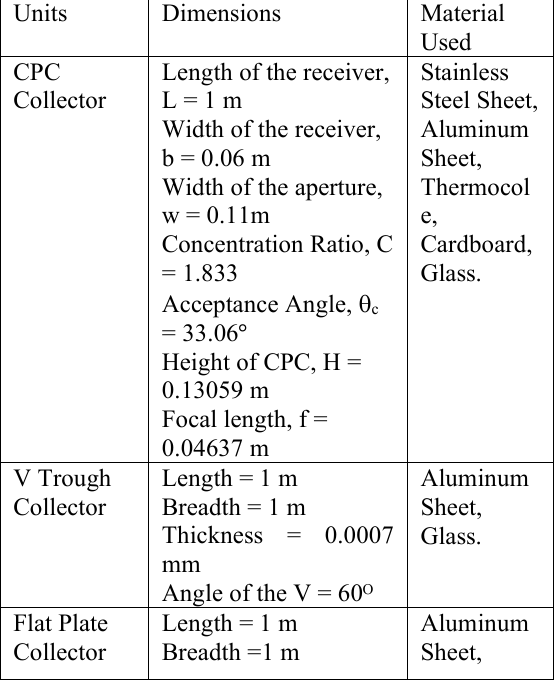
Table 1. Dimensions and materials for